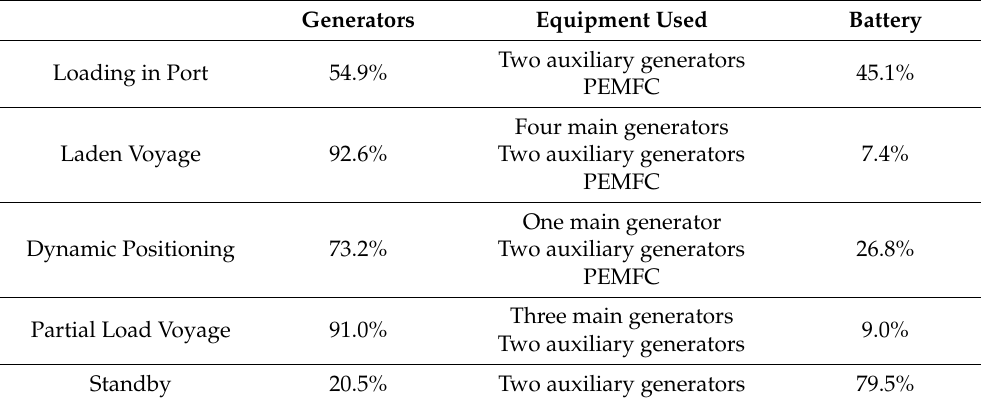
Table 8. Energy contributions in percentages for generators and the batteries that compose the configurations that achieved the highest emission reductions for a 10% higher